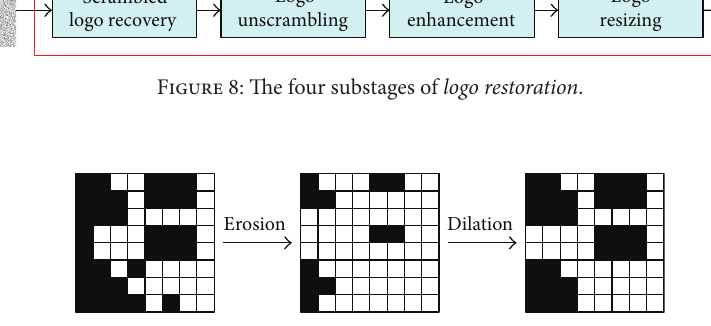
Figure 9: An example of erosion and dilation.